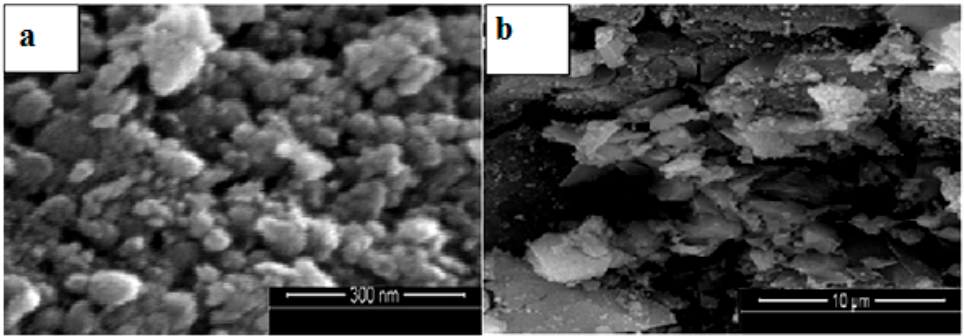
Figure 2. ( a , b ) High Resolution Scanning Electron Microscope (HR-SEM) images of nickel oxide.